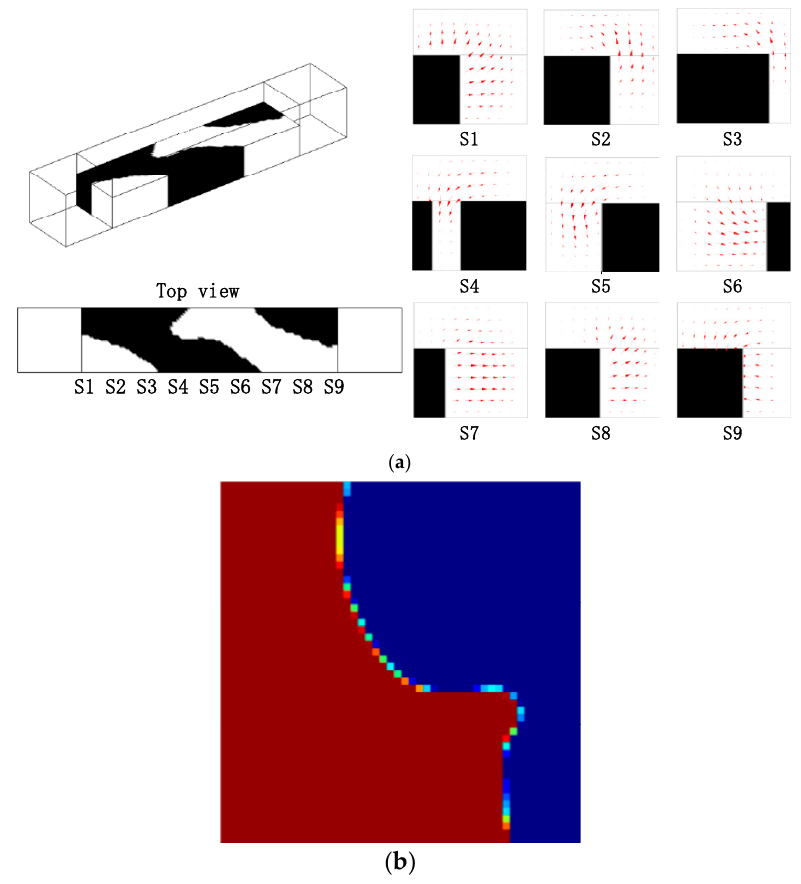
Figure 7. ( a ) Layout of the micromixer for the design domain as shown in Figure 4, where n = 4, Re = 5, and projected velocity vector distribution in the cross sections (S1, S2, S3, S4, S5, S6, S7, S8, S9); the mixing measurement ( C ) = 0.8382; ( b ) the distribution of coarse grain concentration on the outlet.